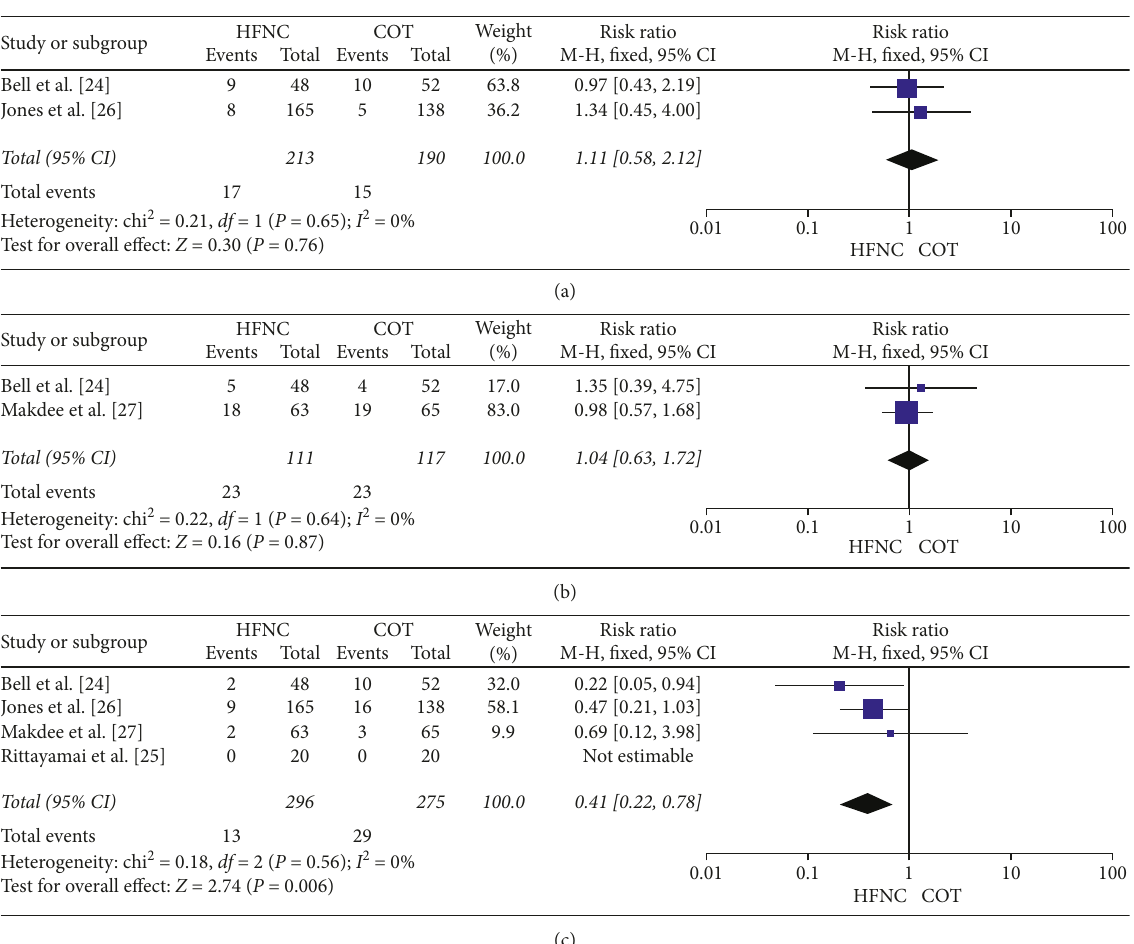
Figure 4: Other secondary outcomes. (a) ICU admission rate: HFNC group versus COTgroup. (b) ED discharge rate: HFNC group versus COT group. (c) Need for escalation: HFNC group versus COT